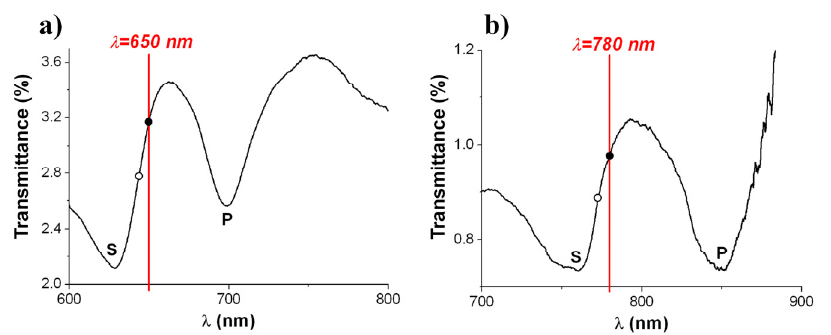
Figure 6. Experimental transmission spectra of 620-nm-period ( a ) and 750-nm-period; ( b ) Al NHAs on PC supports for optical intensity interrogation at 650 nm (DVD) and 780 nm (CD) wavelength, respectively. Solid black dots indicate the operating points of the transducers while hollow dots show the expected operating points of the biosensors, that is, after biological receptor immobilization on the transducers